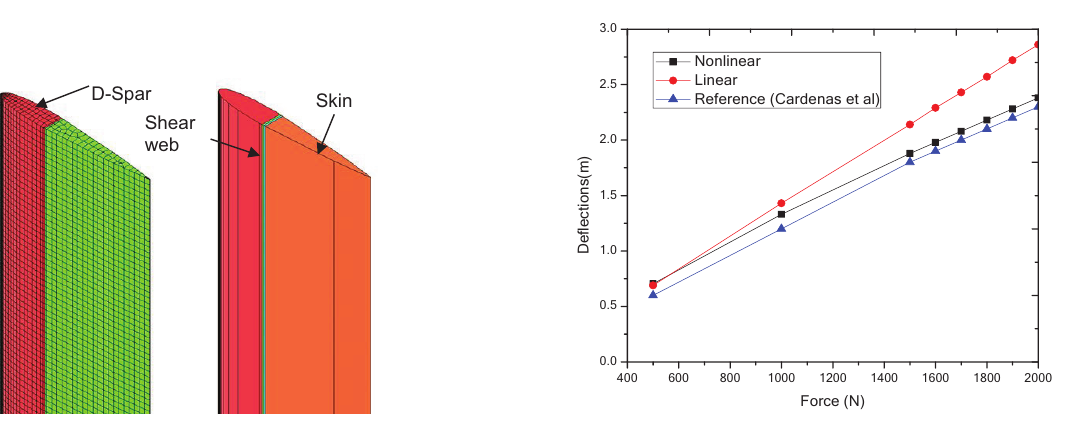
Figure 4. Blade outer geometry profile